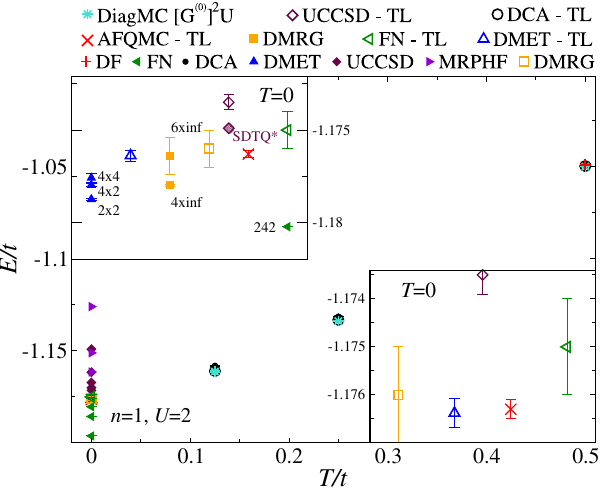
FIG. 13. Data for n ¼ 1 for U=t ¼ 2 . Main panel: Temperature dependence of E=t compiled from various techniques. Solid symbols represent finite systems; open symbols represent extrap- olations to the thermodynamic limit. Finite- T results are shown for DCA (black circles) and DiagMC (blue asterisks), and zero- T data from AFQMC (red crosses), DMET (blue triangles), UCCSD (maroon diamonds), MRPHF (purple triangles), DMRG (orange squares), and FN (green triangles). Top left inset: Zoom- in of the zero- T data from UCCSD, DMET, FN, DMRG, AFQMC, and DMET. Bottom right panel: Enlarged region of the top left inset showing thermodynamic-limit data for DMRG, DMET, UCCSD, FN, and AFQMC at T ¼ 0 , including error bars, extrapolated to the infinite system size.